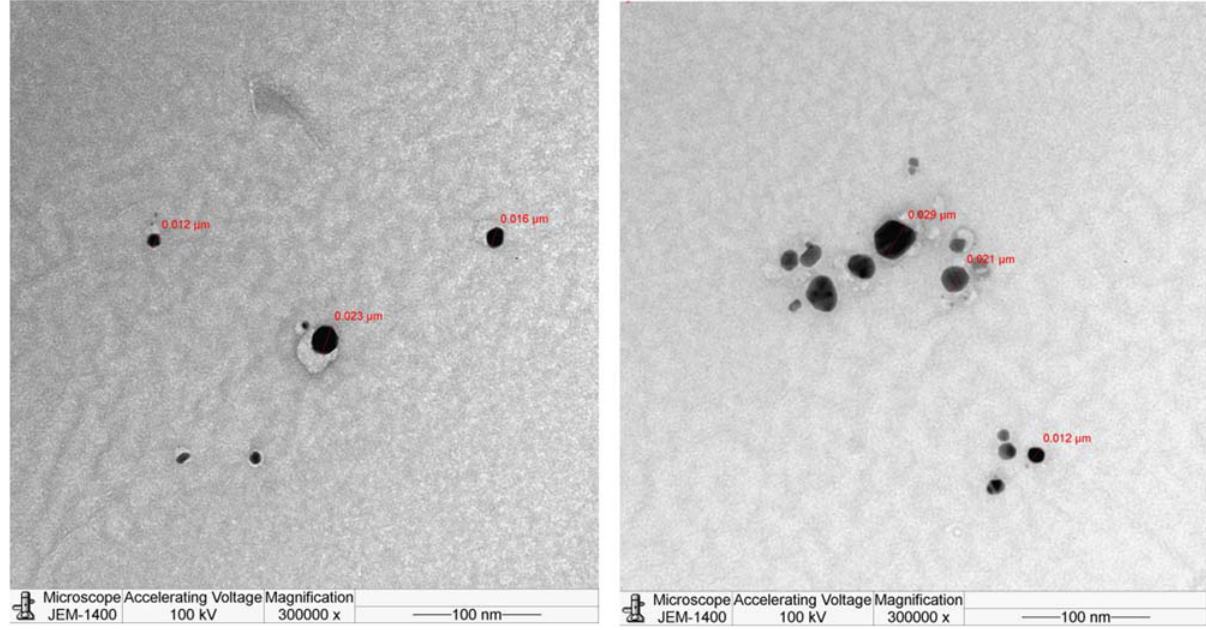
Figure 6: TEM micrograph of the biosynthesized AgNPs prepared with aqueous R. o ffi cinalis leaf extract ( particle size shown in range from 12 to 22 nm )